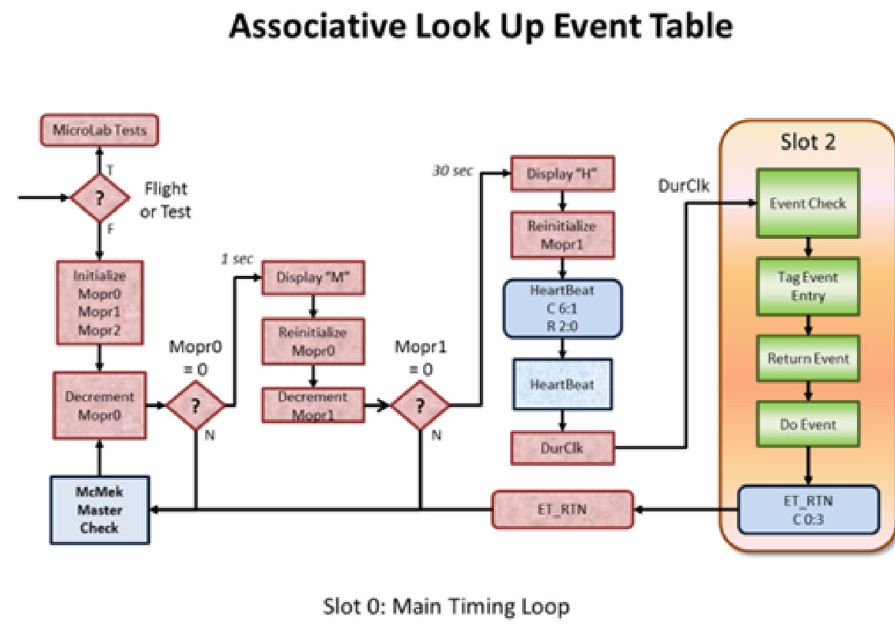
Fig. 4 Basic BIOS template ( left ) and the Associate Event Table BIOS template ( right